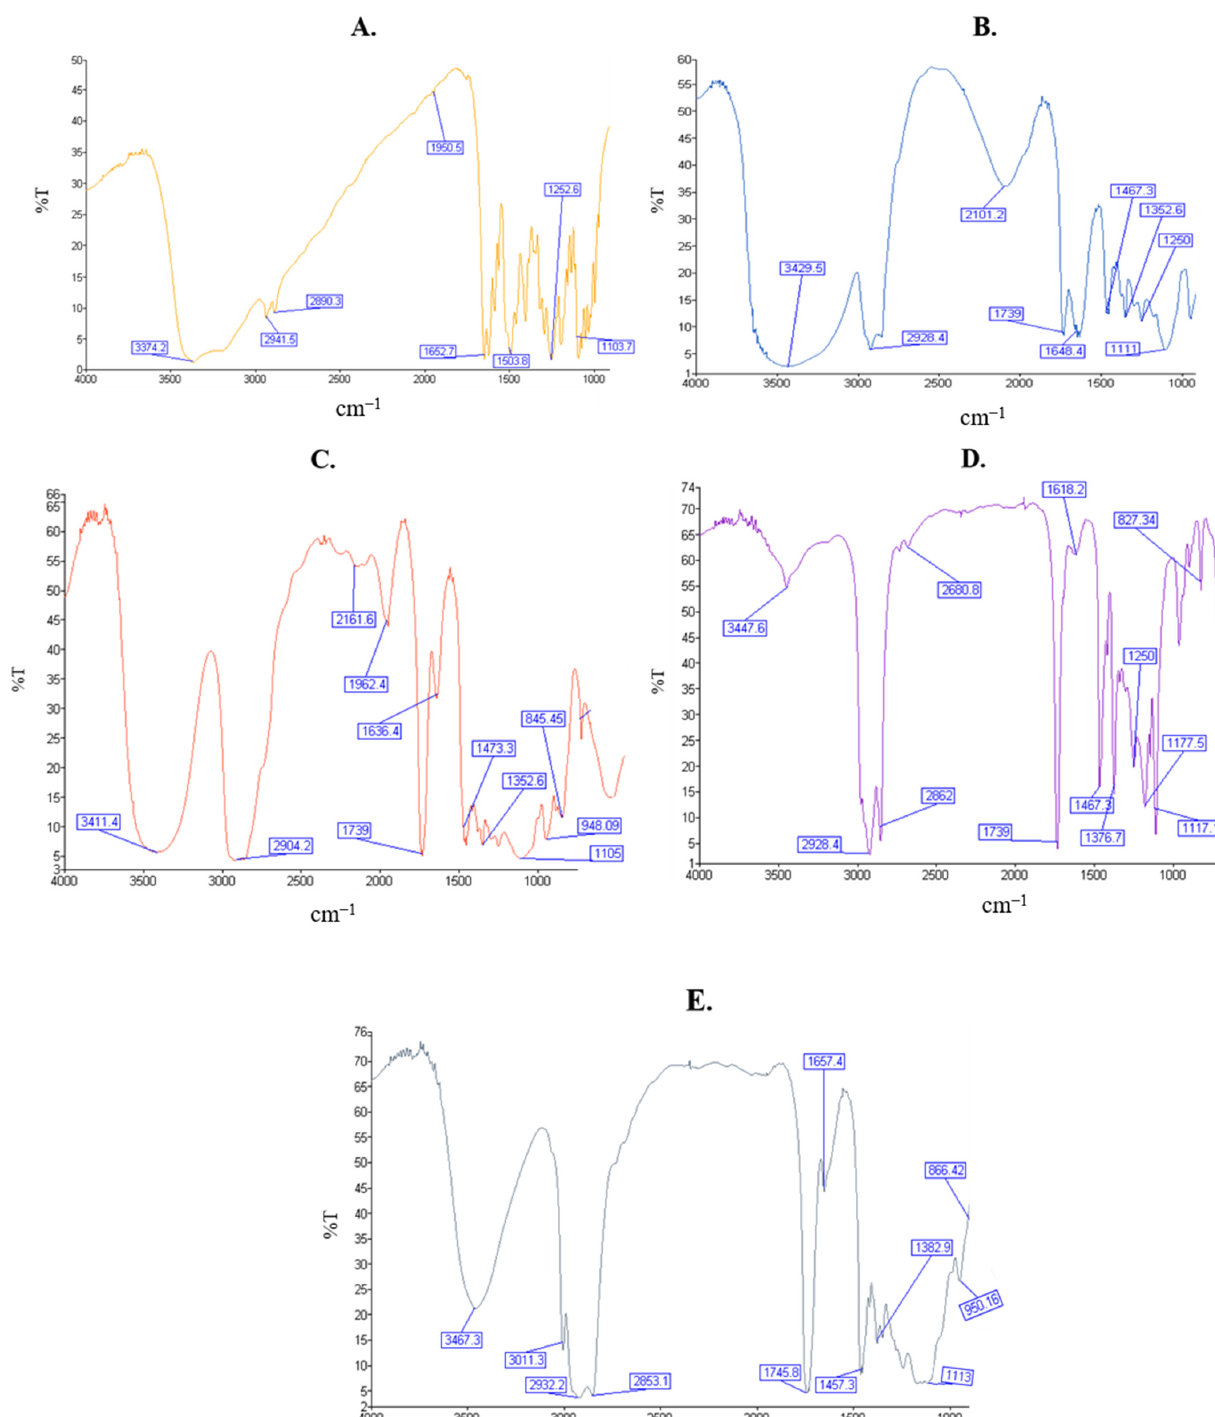
Figure 6. FT-IR spectrum of: mangiferin ( A ), microemulsion ( B ), Labrasol ( C ), IPP ( D ) and Gelucire ( E ) .